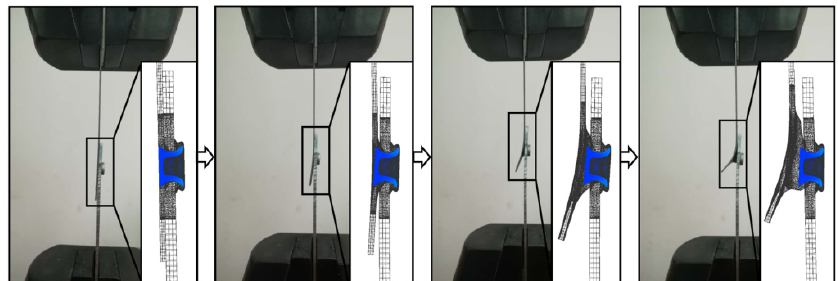
Figure 7. The tensile test process of the SA joint.